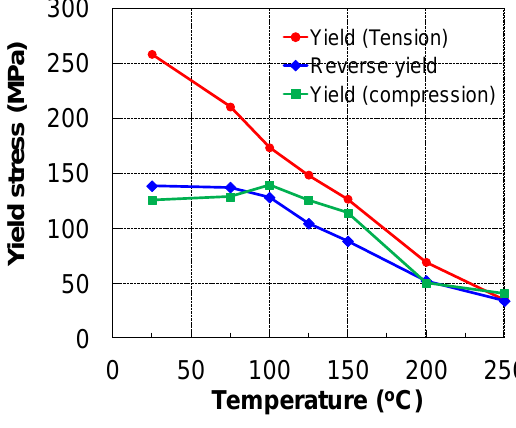
Figure 16. Dependence of yield stress on temperature for the tested